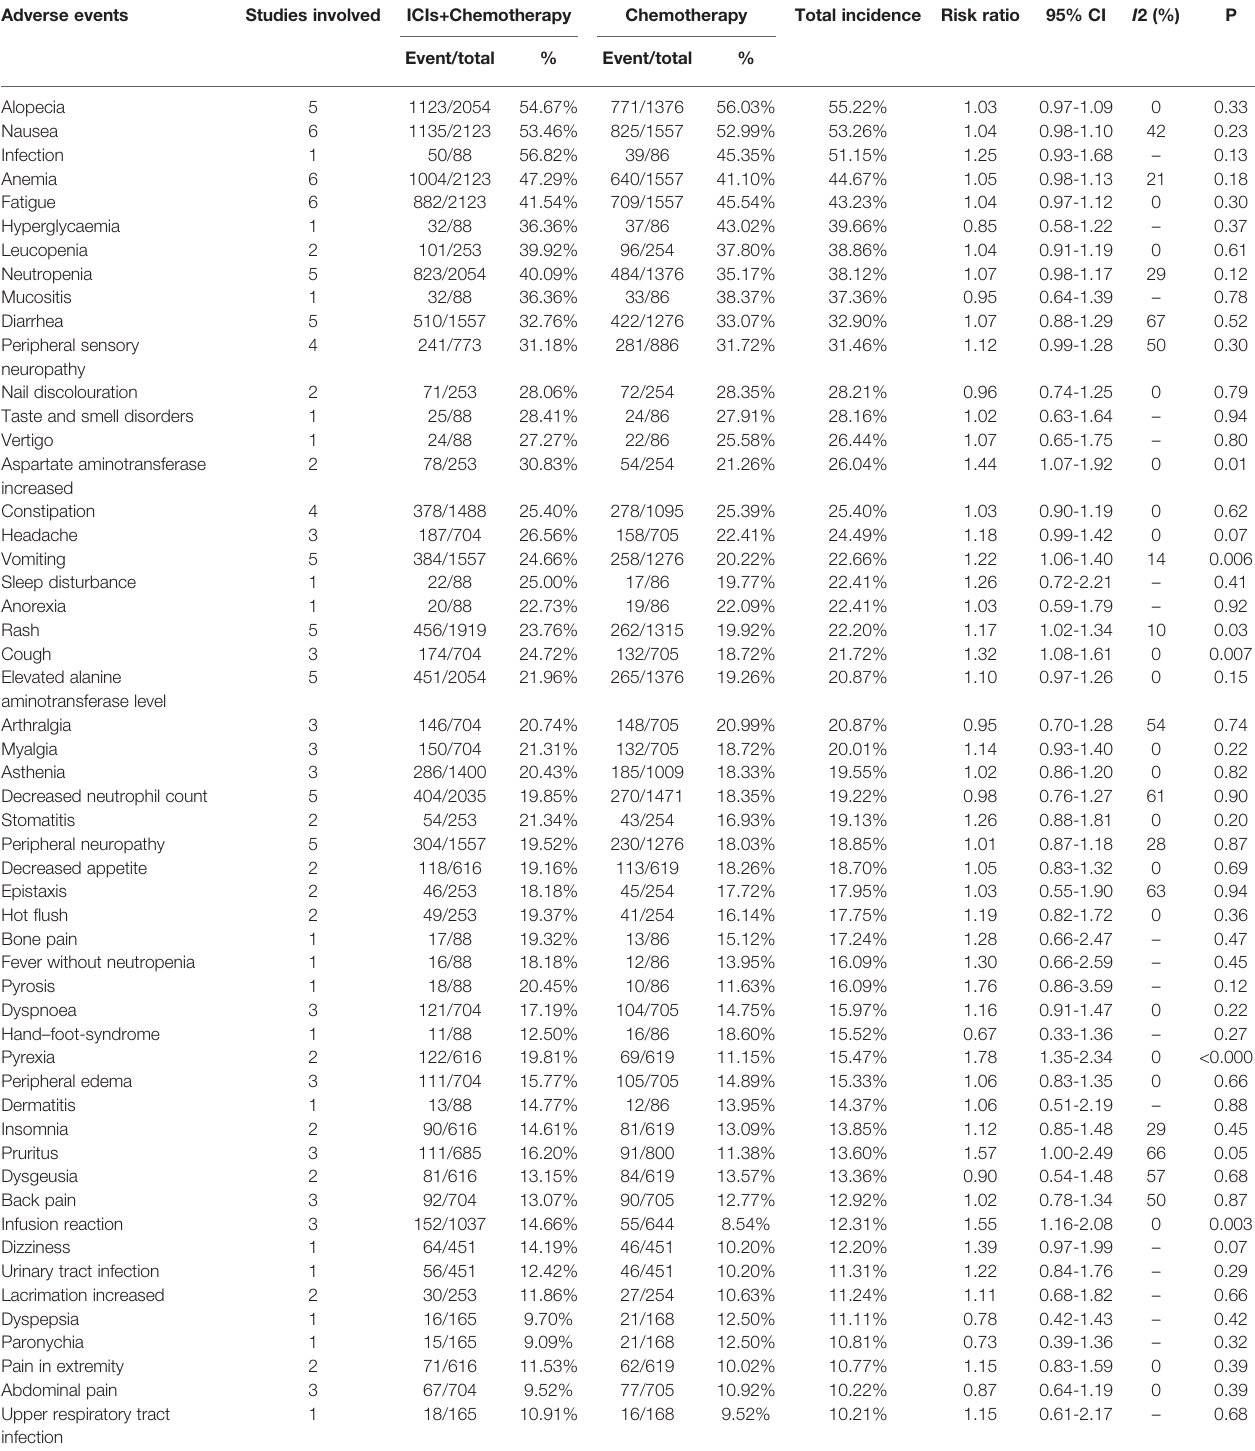
TABLE 4 | Total adverse events an incidence of more than 10% according to combination of two